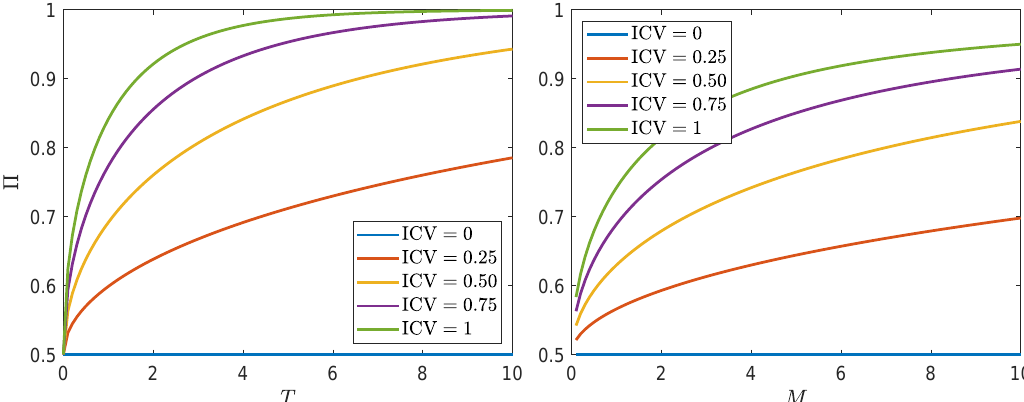
Figure 3. Outperformance probability (OP) depending on the inverse coefficient of variation (ICV) and the (maximal) holding period. On the left-hand side, the holding period T is considered fixed, whereas on the right-hand side, T is supposed to be uniformly distributed between 0 and M years.